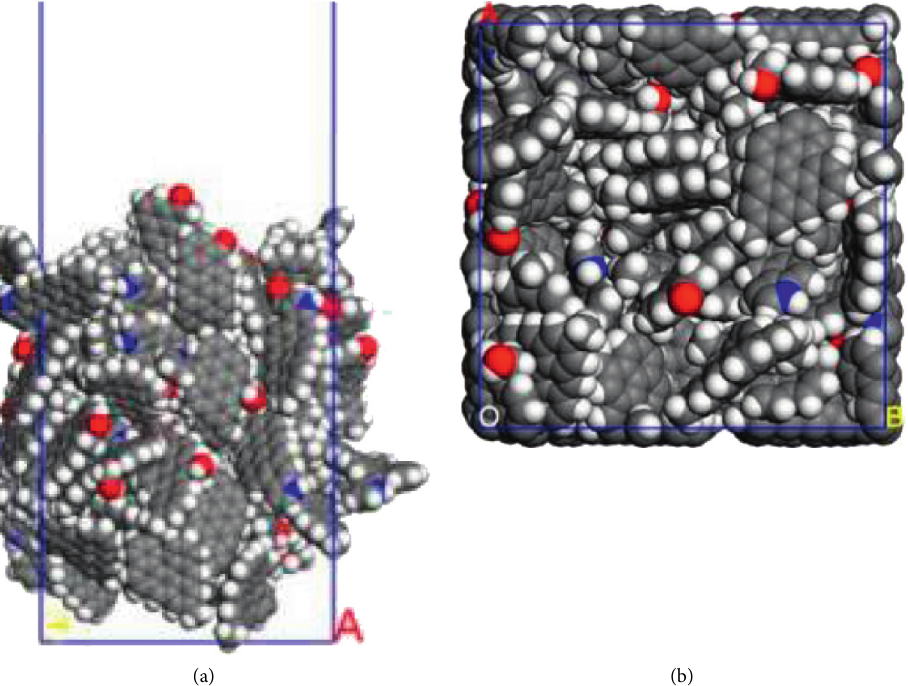
Figure 2: (a) Side view of the coal surface; (b) top view of the coal surface (the gray balls are carbon atoms, the red balls are oxygen atoms, the blue balls are nitrogen atoms, the white balls are hydrogen atoms, and the blue line is the model